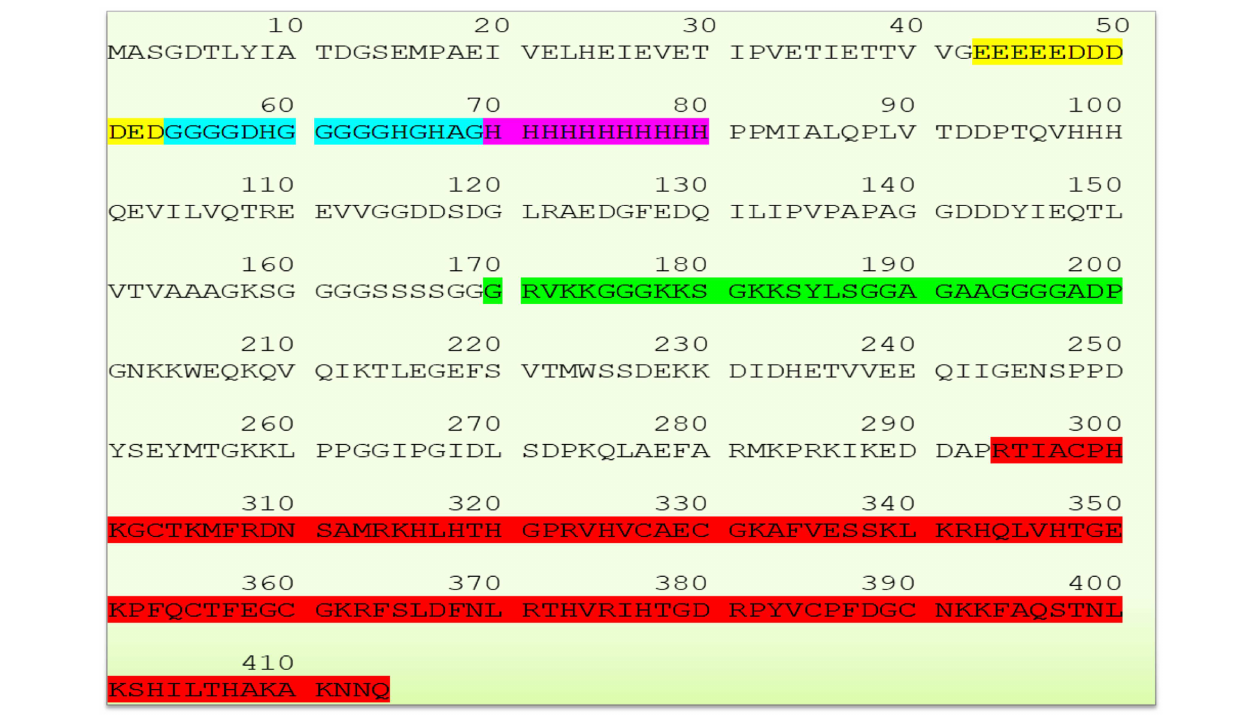
FIGURE 1 | Schematic representation of YY1 sequence and its highlighted features (Glutamic and Aspartic acid rich region represented in yellow color, Glycine rich region in blue color, histidine rich region in magenta color, transcriptional repressive region in green color, and zinc finger sequence in red color, respectively). YY1 protein sequence was retrieved from UniProt database (UniProt entry ID: